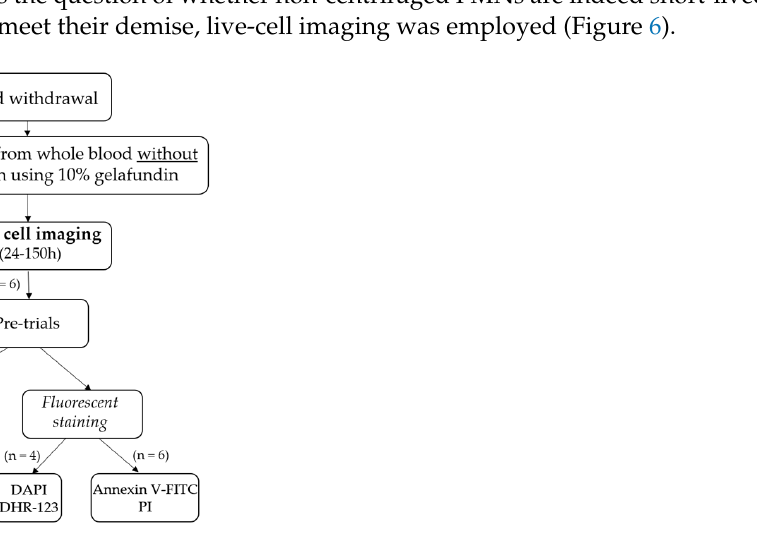
Figure 6. Schematic presentation of the used methods. On the one side, fluorescence analysis is performed using 4 ′ ,6-diamidino-2-phenylindole (DAPI) and dihydrorhodamine 123 (DHR-123) and on the other side, using annexin V-FITC and propidium iodide (PI).